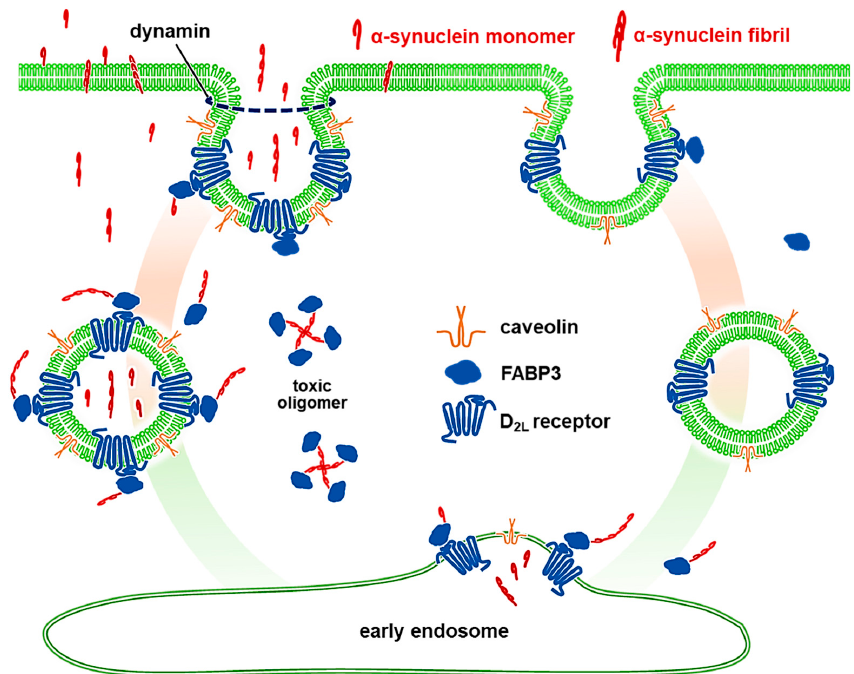
Figure 8. Schematic illustration of α -synuclein uptake in dopaminergic neurons. We demonstrated that dopaminergic neurons require dopamine D 2L receptors, FABP3, and dynamin/caveolin-1-coupled caveolae formation to take up α - synuclein monomers as well as fibrils. In this context, FABP3 and caveolin can interact with α -synuclein, and dopamine D2L receptors bind to FABP3. Caveolin and dopamine D 2L receptors are abundant in lipid raft. The caveolae-mediated endocytosis is coupled with dopamine D 2L receptors and FABP3, and the structure is abundantly associated with α - synuclein. The structure of D 2L /FABP3 in the endocytotic process holds α -synuclein and does not release until its